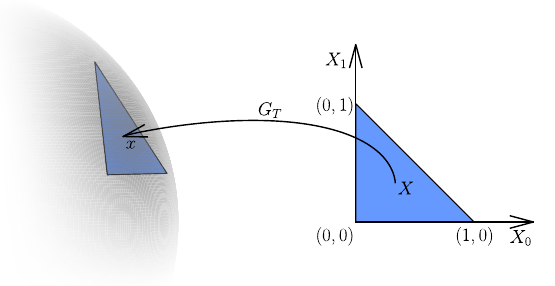
Fig. 1. The transform G T maps the reference cell T 0 to cell T , which in this case approximates part of a sphere. The point X in reference space is mapped to the point x in physical space: x = G T ( X ).